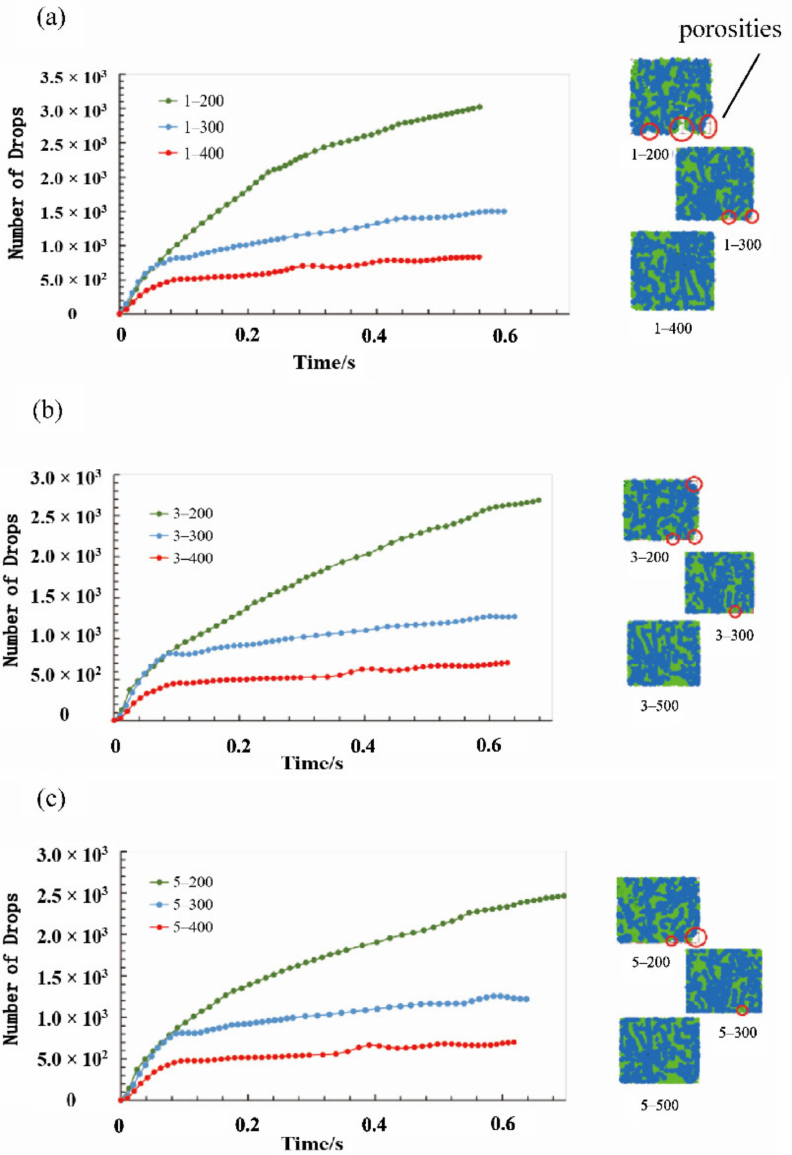
Figure 7. The development of drops number along the simulation and the cross section of the sealing grease models at ( a ) viscosity grade 1, ( b ) viscosity grade 3, and ( c ) viscosity grade